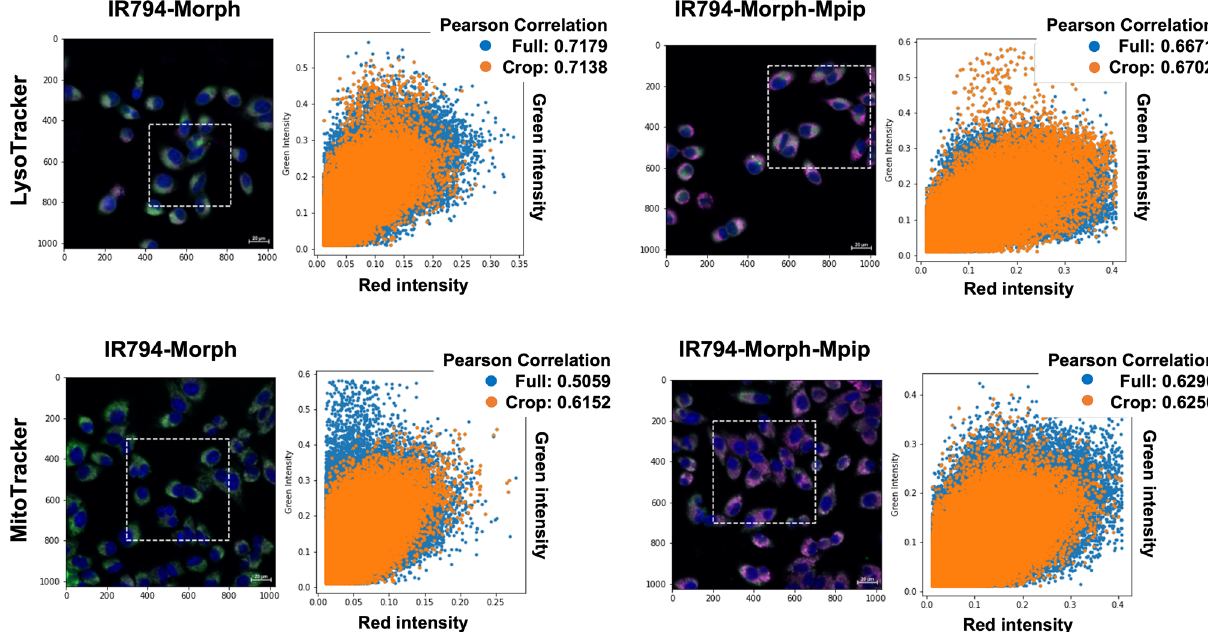
Figure 8. Confocal images of HepG2 cells incubated with 1 µM of IR794-Morph and IR794-Morph-Mpip for 15 min and colocalization of the probes with LysoTracker green (Pearson’s R value = 0.72 for IR794-Morph and 0.67 for IR794-Morph-Mpip ) and MitoTracker (Pearson’s R value = 0.51 for IR794-Morph and 0.63 for IR794- Morph-Mpip ). Pearson’s correlation coefficient between the two intensities was performed in python, using a built-in function from scipy statistical